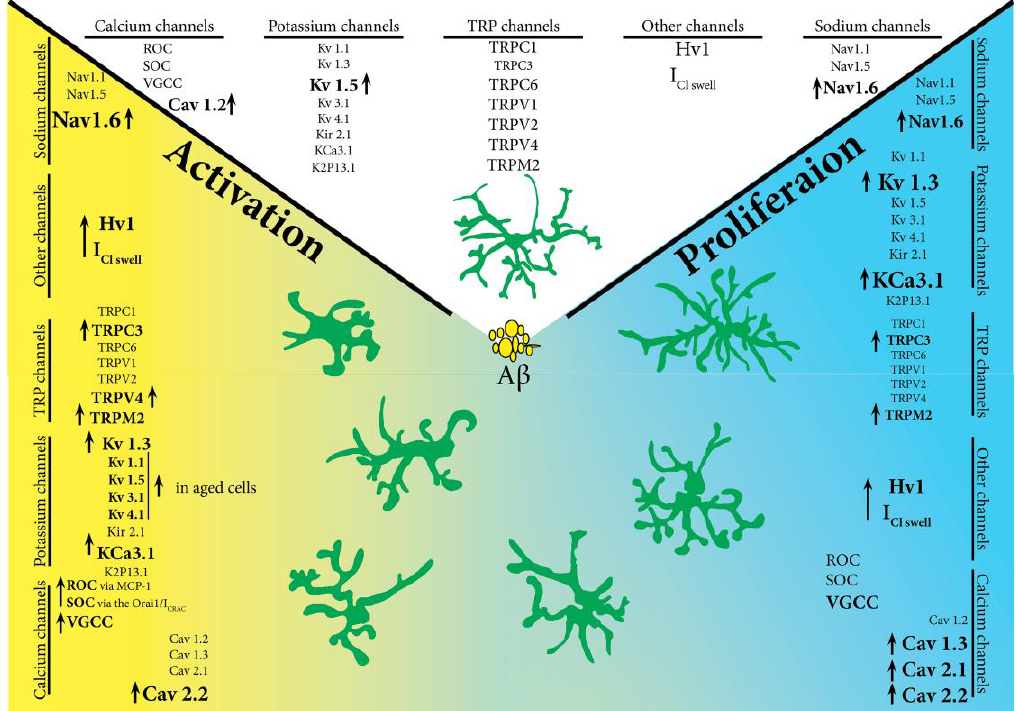
Figure 2. Changes in ion channel expression in the presence of amyloid beta.